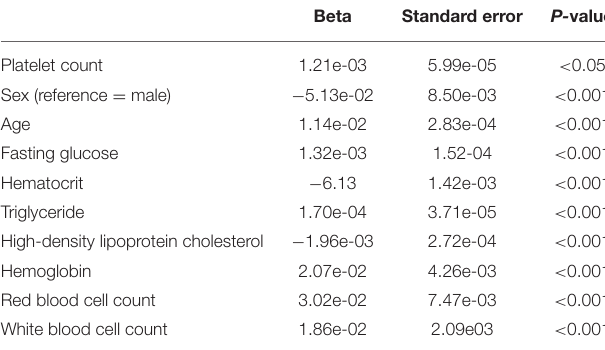
FIGURE 4 | Frequency distribution of hypertension and platelet counts in the study population. (A) Pie chart displaying fractions of the study population with and without hypertension. (B) Logistic regression without adjustment of confounders shows the probability of getting hypertension when the platelet count increases. The coefficient of the platelet count is − 0.0026716 with the P = 1.85e-14. TABLE 2 | Logistic regression analysis results, with hypertension as outcome and platelet count as exposure/risk factor, and with known confounders